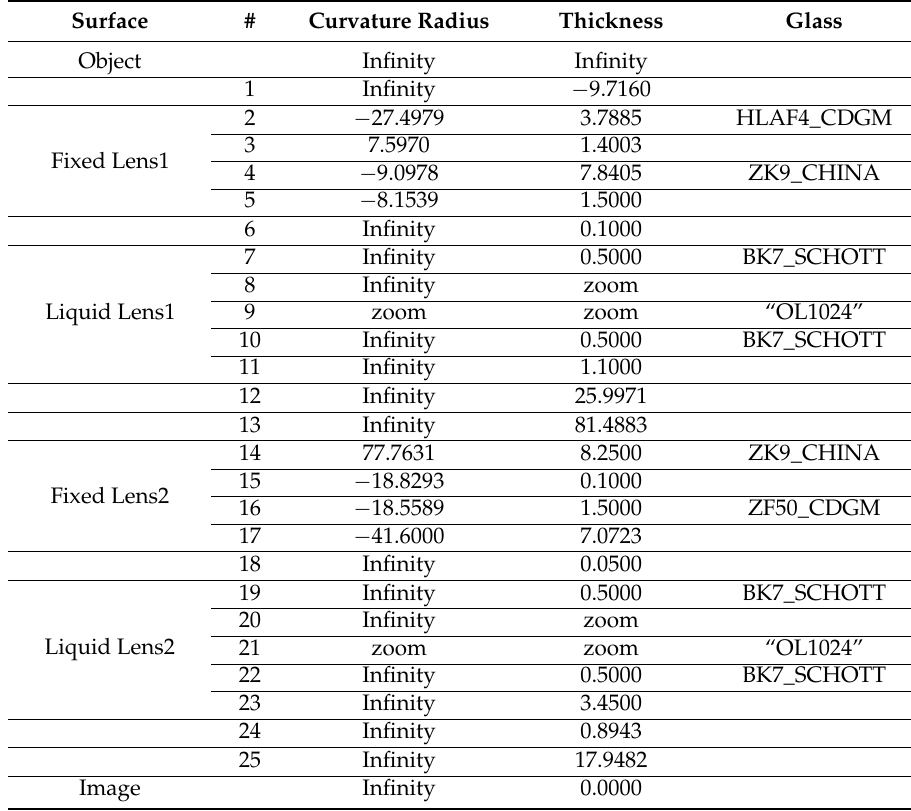
Figure 3. Initial lens structure of the optical system. Table 2. General parameters of the zoom system.